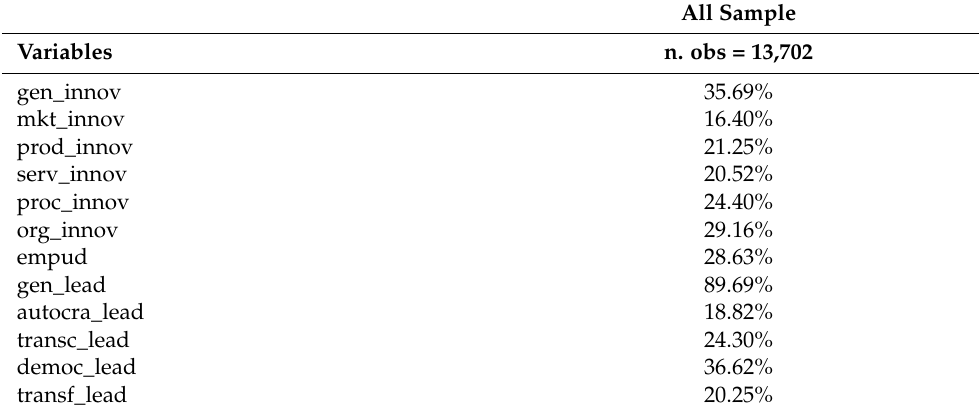
Table 3. Proportion of firms according to the different innovation types and leadership